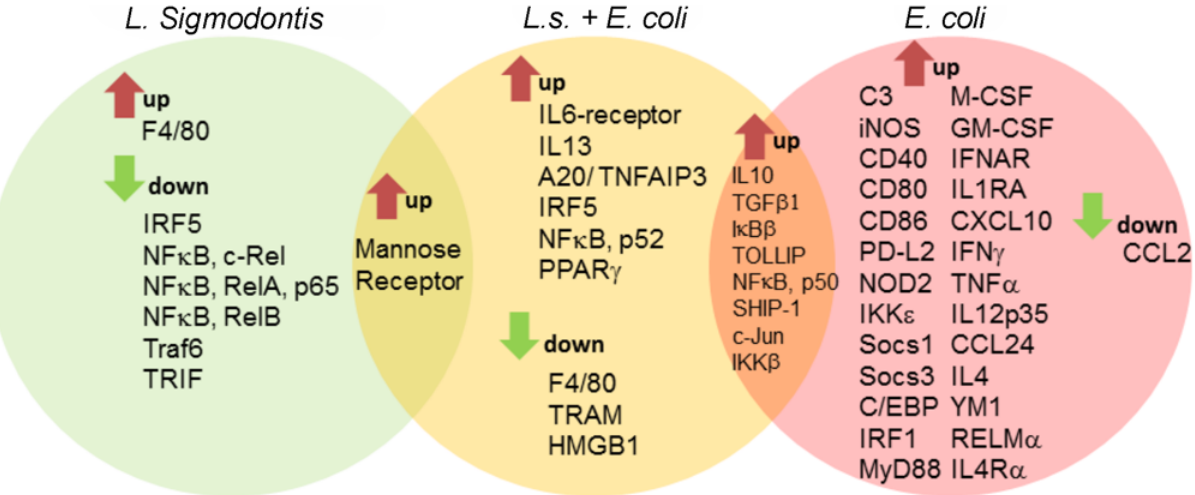
Figure 3. Macrophage transcriptional analysis reveals a less inflammatory phenotype in L. sigmodontis -infected mice during E. coli challenge. Gene expression profiles of peritoneal macrophages from L. sigmodontis ( L.s. )-infected (left), L.s. -infected and E. coli challenged (middle) as well as E. coli challenged control mice (right) following PCR array analysis. Shared and exclusively regulated genes among the experimental groups were analyzed in comparison to gene expression of na ï ve control macrophages (cut-off: p < 0.05 and > 2-fold change). Statistical significances were tested by student ’ s t-test of the replicate 2 ^ (-Delta Ct) values for each gene in the control group and treatment